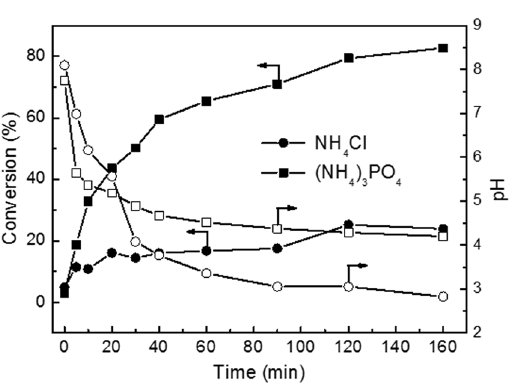
Figure 12. Evolutions of ammonia conversion and pH of NH 4 Cl and (NH 4 ) 3 PO 4 solutions over Ru-Cu/C catalyst. Conditions: